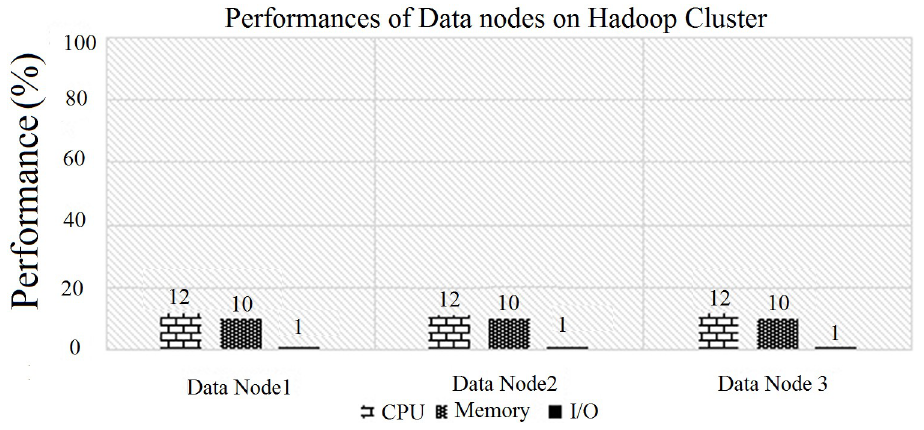
Fig 10. CPU, memory, and IO performances of